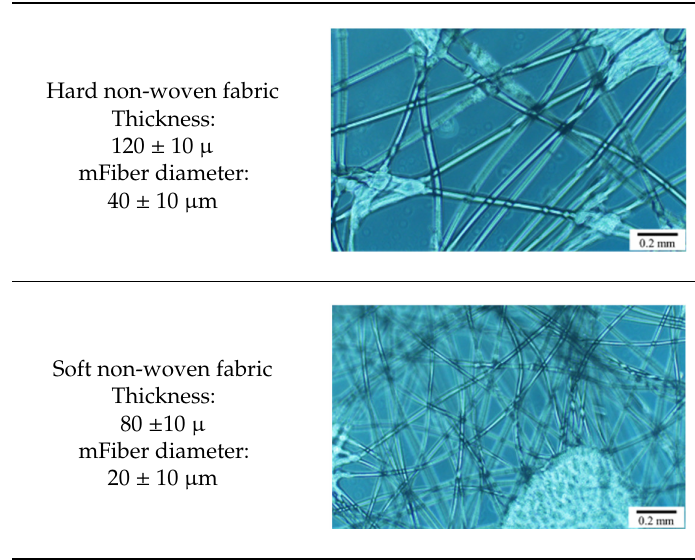
Figure 5. Viscoelastic measurements: ( a ) Fabricated dura-mater model; ( b ) Three-element viscoelastic model; ( c ) Measurement setup for viscoelasticity of dura-mater models. Table 1. Fabric materials for dura-mater